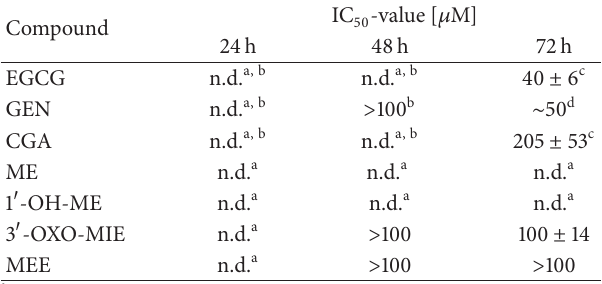
Table 1: Cytotoxic properties of the test compounds in HT29